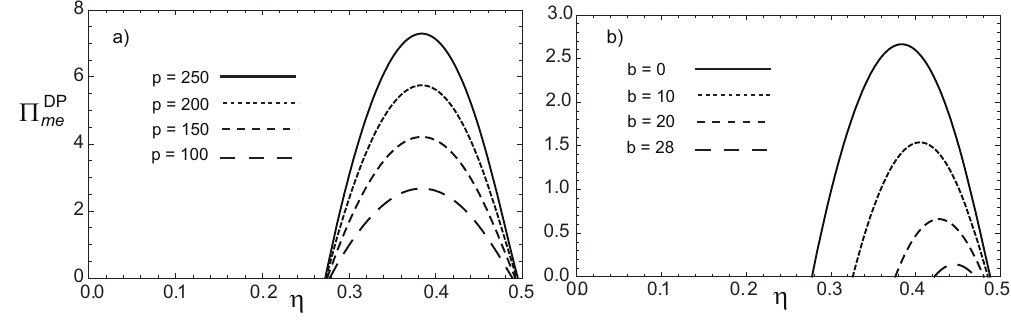
Figure 7. Profit function (cid:5) DP in terms of the engine’s efficiency η under a DP heat transfer me law for a) b = 0 and taking several values of p and b) p = 100 and taking several values of b